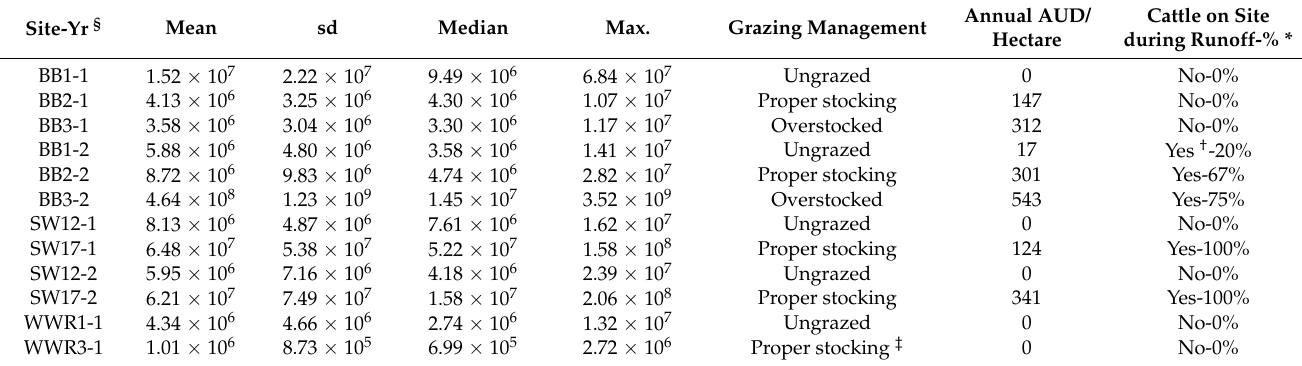
Table 1. Comparison of annual AllBac concentrations (copies/L) with grazing management, stocking rate (AUD/hectare), and cattle presence during runoff events.